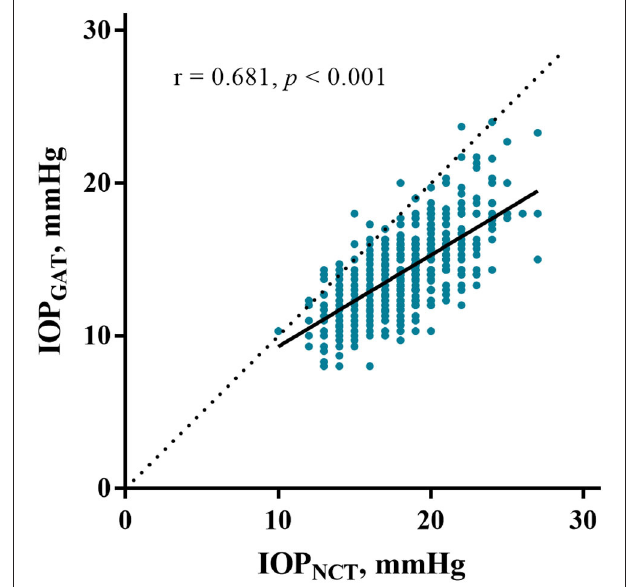
FIGURE 1 | Correlation between IOP NCT and IOP GAT . The scatter plot and regression line (solid line) show comparisons between IOP NCT and IOP GAT values in eyes with high myopia. The dotted line represents the line of identity, and r indicates Pearson’s correlation coefficient. IOP NCT , intraocular pressure measured with non-contact tonometer; IOP GAT , intraocular pressure measured with Goldmann applanation